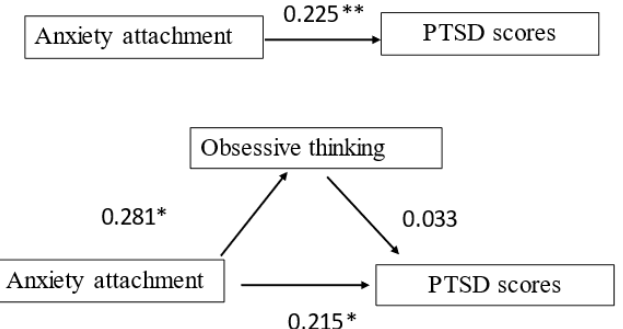
Figure 3. The mediating effect of obsessive thinking on attachment anxiety and PTSD scores. ** p < 0.01, * p < 0.05. ** p < 0.01, * p <